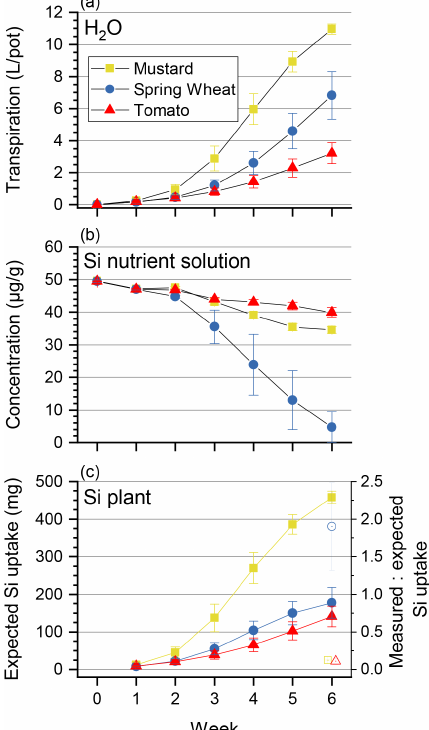
Figure 1. Cumulative transpiration (a) , Si concentration in the nutri- ent solution (µgg − 1 , b ), and the expected Si uptake through transpi- ration of tomato, mustard, and spring wheat for 6 weeks (c) . Shown is the mean ± standard deviation from three pots with four plants each. (c) A ratio of measured and expected Si uptake (open sym- bols) of greater than 1 indicates an active uptake mechanism and a ratio much smaller than 1 a rejective